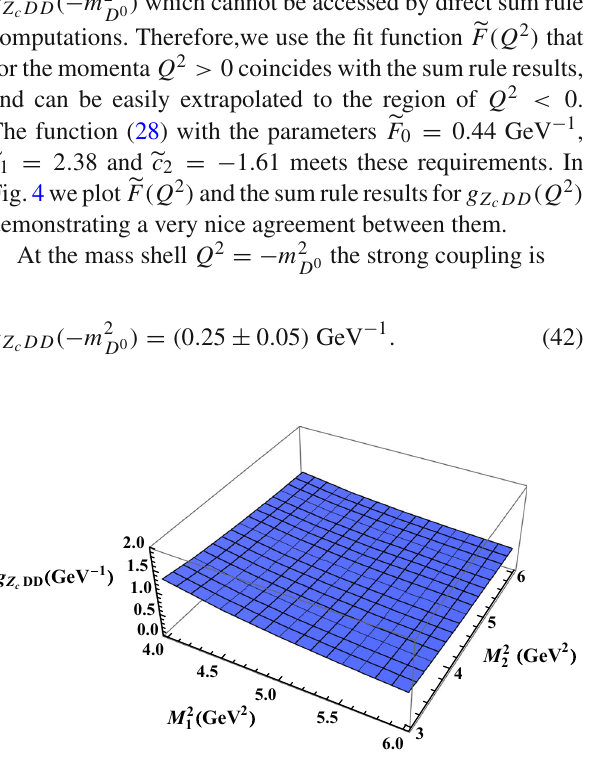
( Q 2 ) as a function of the Borel c DD , M 2 ) at the fixed ( s , s (cid:4) ) = ( 20 , 8 ) GeV 2 0 1 2 0